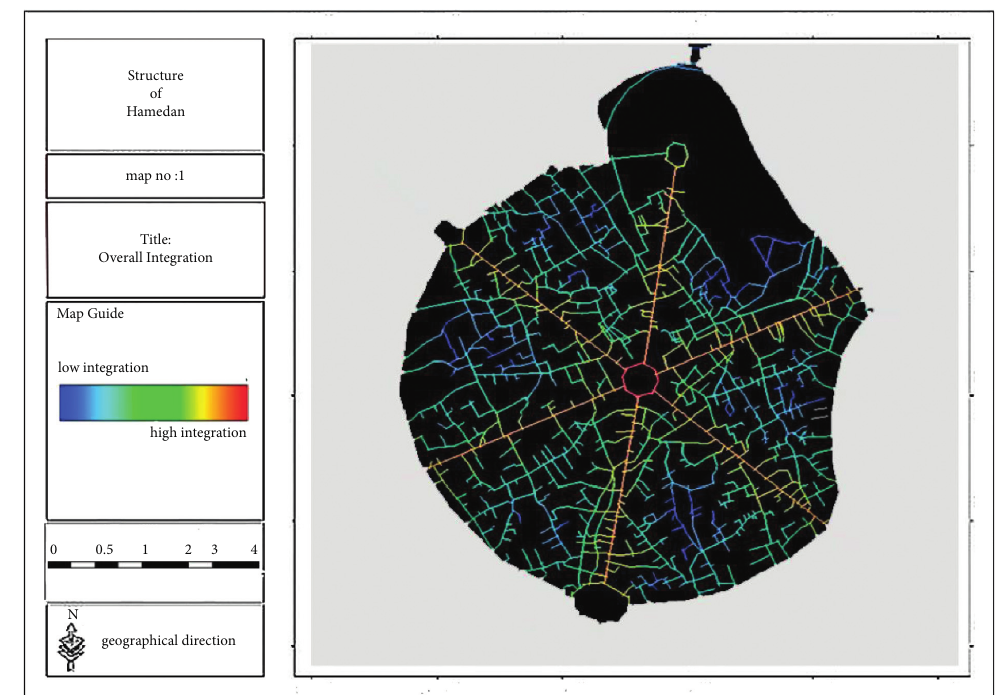
Figure 4: Map of the spatial structure of the city of